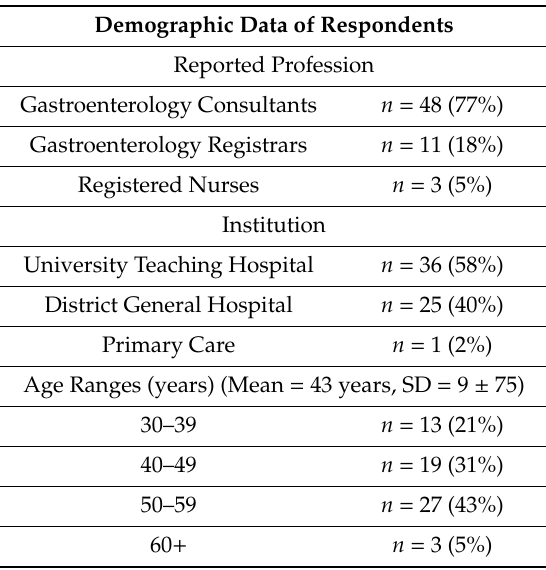
Table 1. Demographic Data of Respondents.